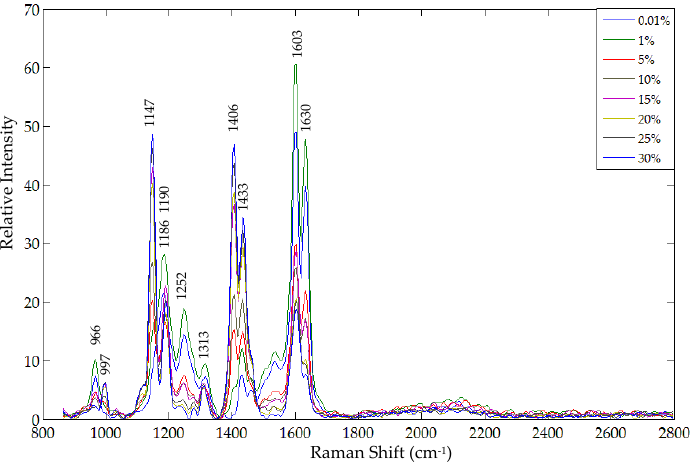
Figure 5. Corrected FT-Raman spectra for representative samples at each concentration level.